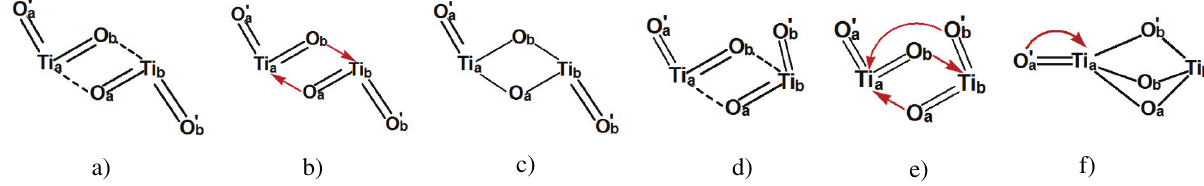
Figure 3 . Proposed Lewis structures for studied dimers.